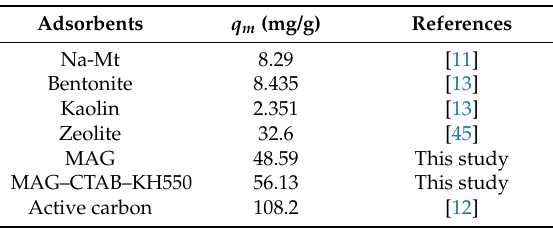
Table 2. Phenol adsorption on different absorbents at 25 ◦ C with an initial concentration of phenol at 100